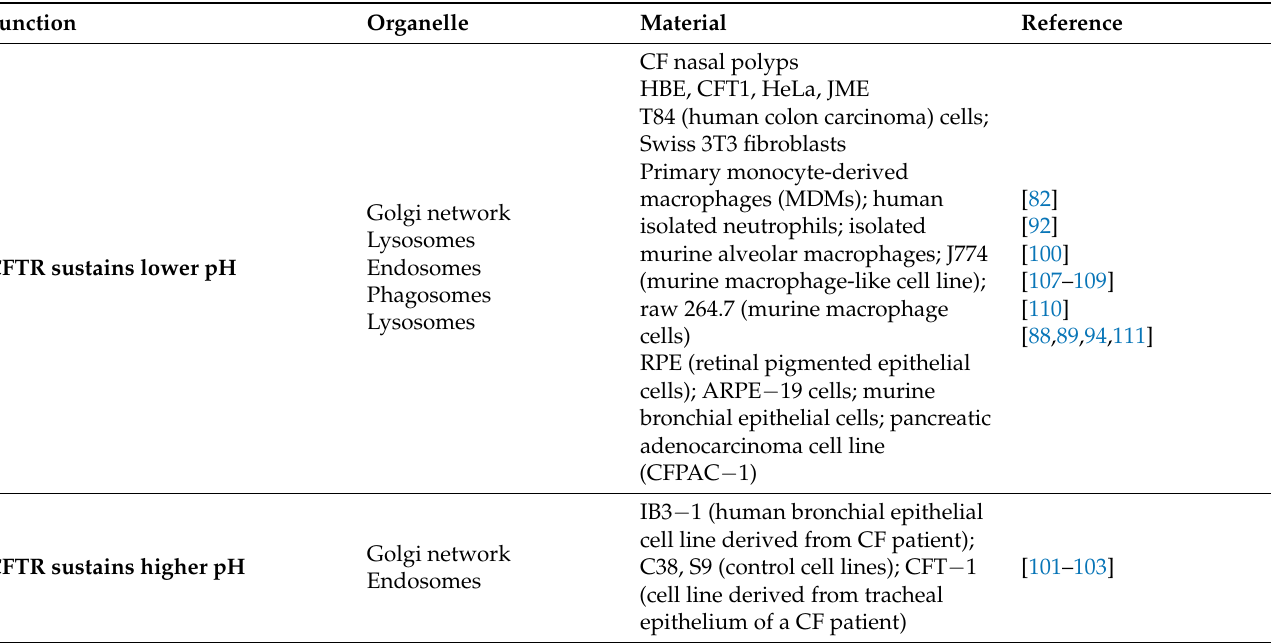
Table 1. The role of CFTR in the intracellular vesicles shown in the context of the source material.